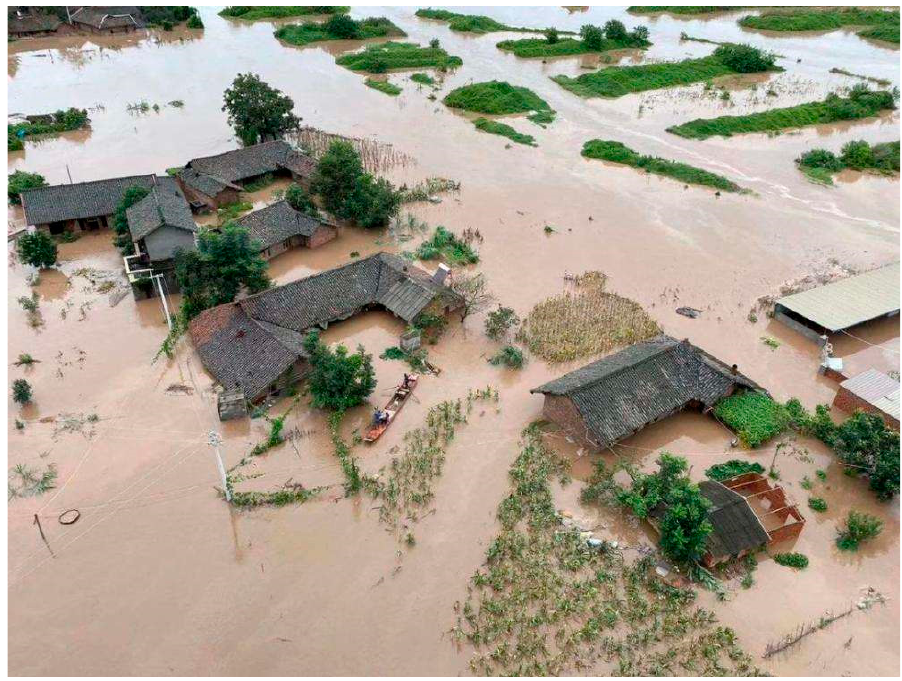
Figure 2. Photograph showing the flooding hazards in southwestern China (17 August 2020).